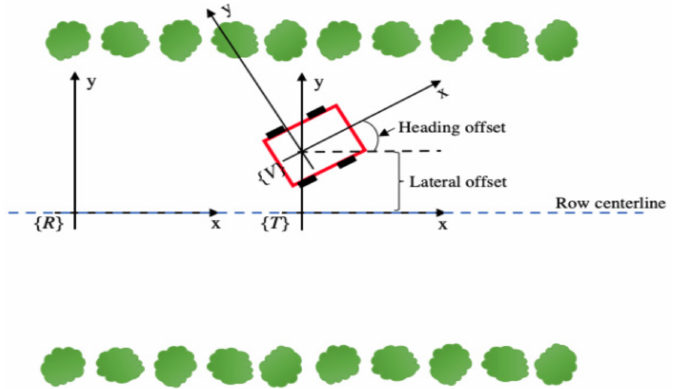
Figure 4. The figure shows the orchard row frame {R}, the vehicle frame {V}, the template frame {T}, and the definition of lateral and heading